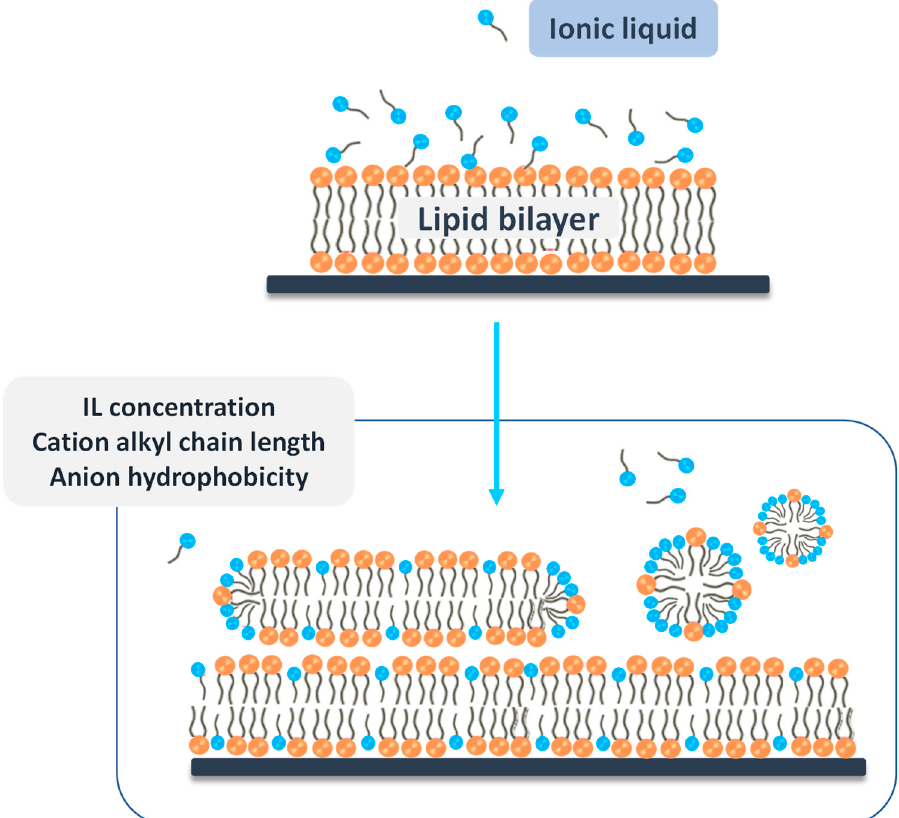
Figure 21. Schematic representation of IL effect and insertion into the lipid bilayer proposed in